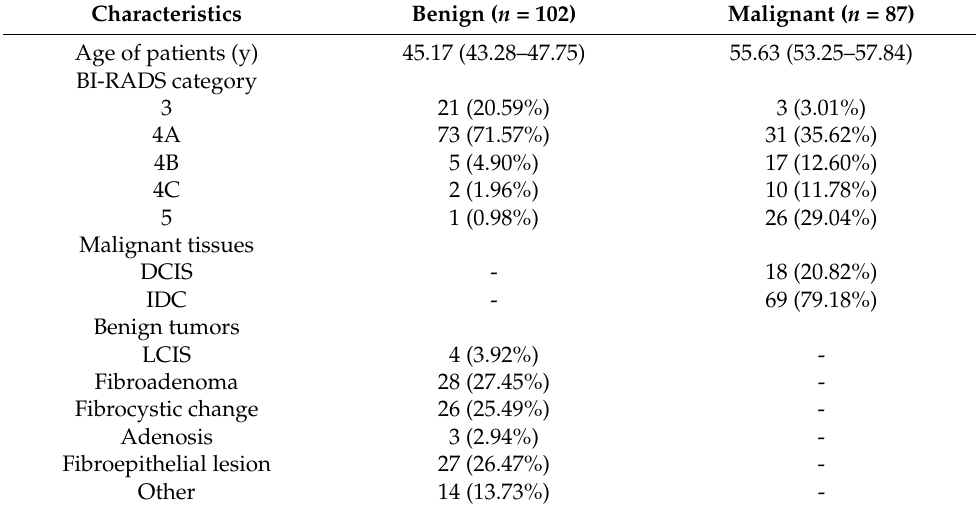
Table 1. Patient and image characteristics.